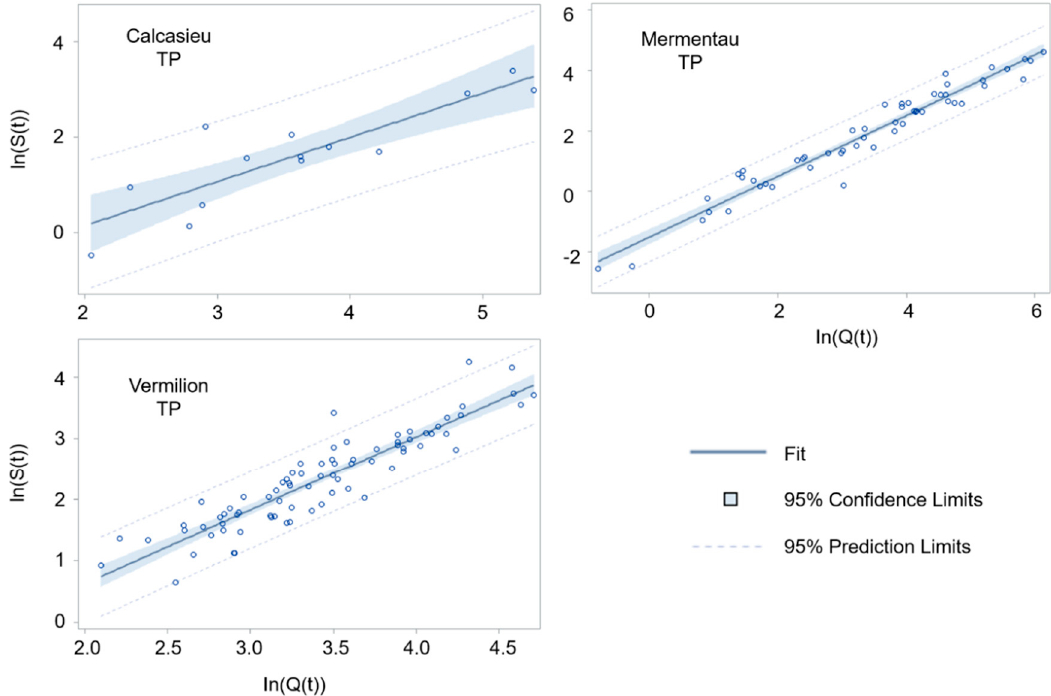
Figure A4. Statistical performance of the rating curves (Table 1) for estimating TP daily fluxes of the Calcasieu (Kinder), Mermentau, and Vermilion Rivers from 2010 to 2017 using data collected from LDEQ.